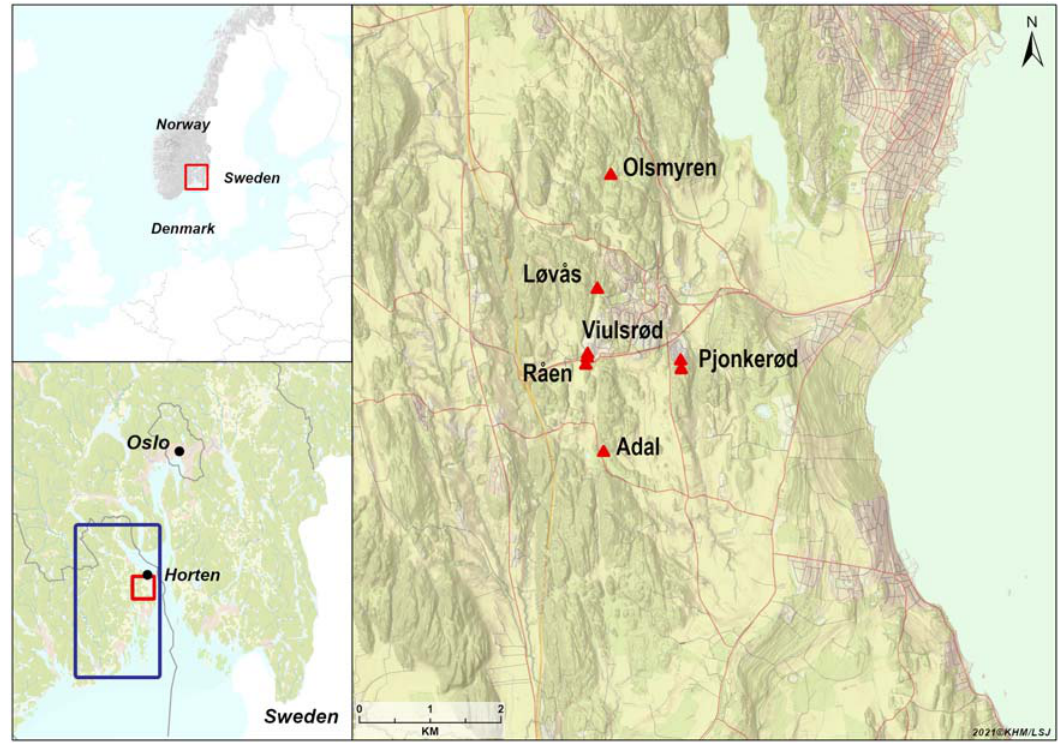
Figure 1: Map showing the project area in Norway and N - Europe. Sites named in the text are plotted on the map to the right. Blue square refer to the map section in Figure 11. Map: Linnea S. Johannessen, MCH, University of